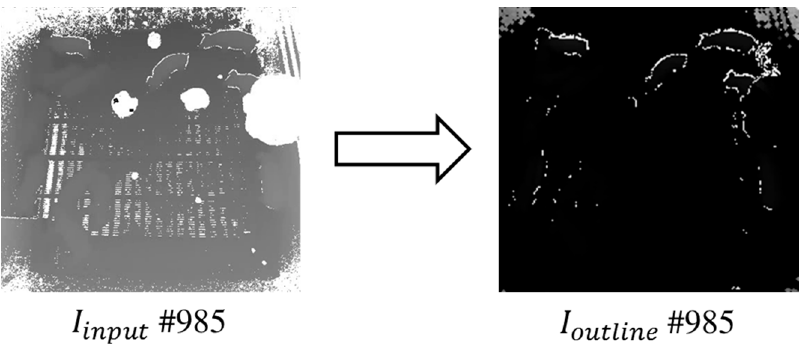
Figure 6. Standing-pigs within the bold box have undefined outlines.